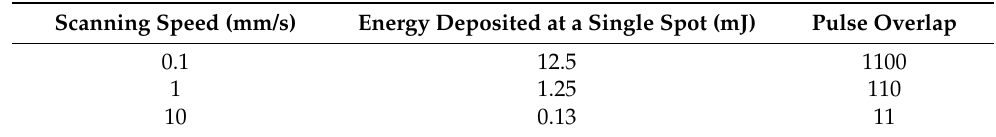
Table 1. Laser parameters for each scanning speed.